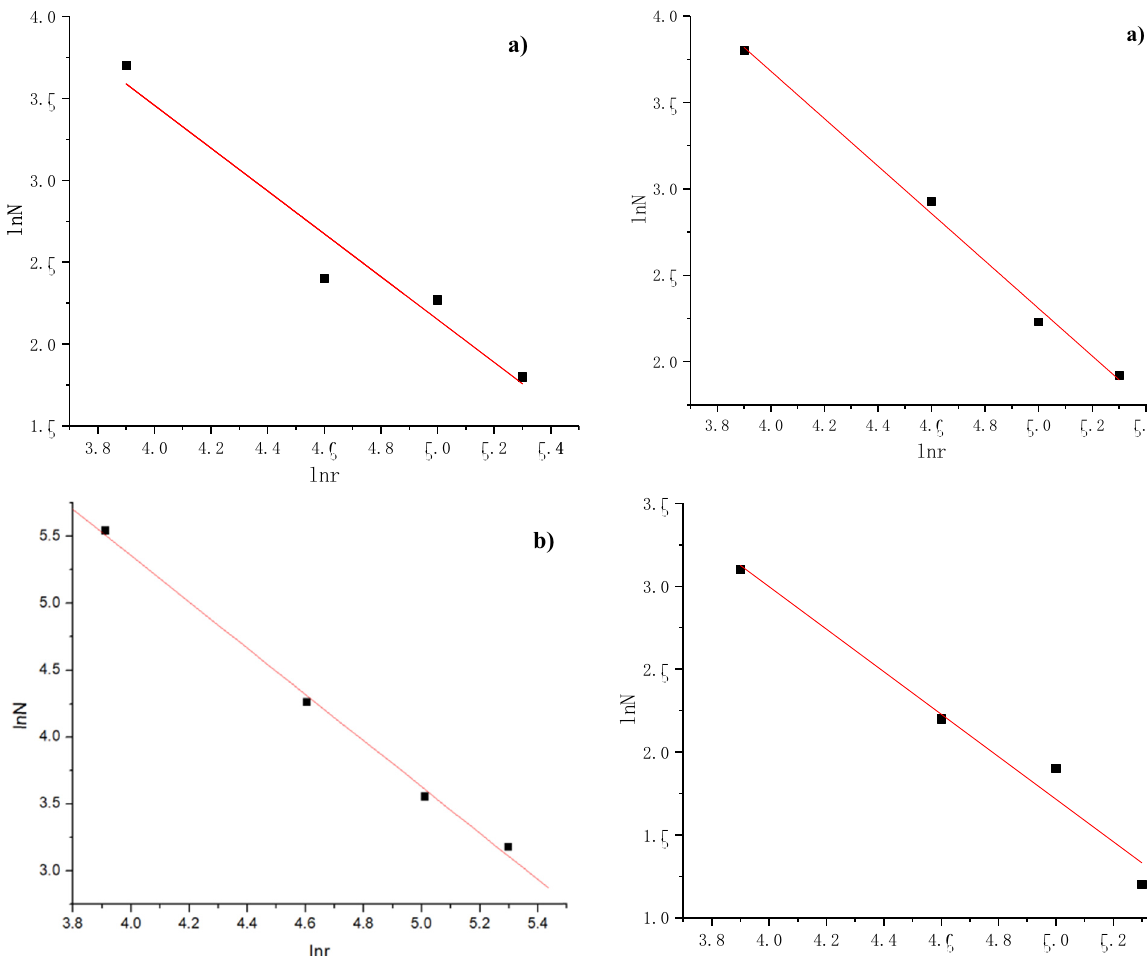
Table 5. Their correlation coe ffi cients are all larger than 0.99, which indicates that the outline of sand group embodies signi fi cant self - similarity and fractal character - istic. Thus, the D is technically capable to be the numer - ical evaluation indicator for the recycled sand; the phy - sical relation between D and aggregate quality will be discussed as below.